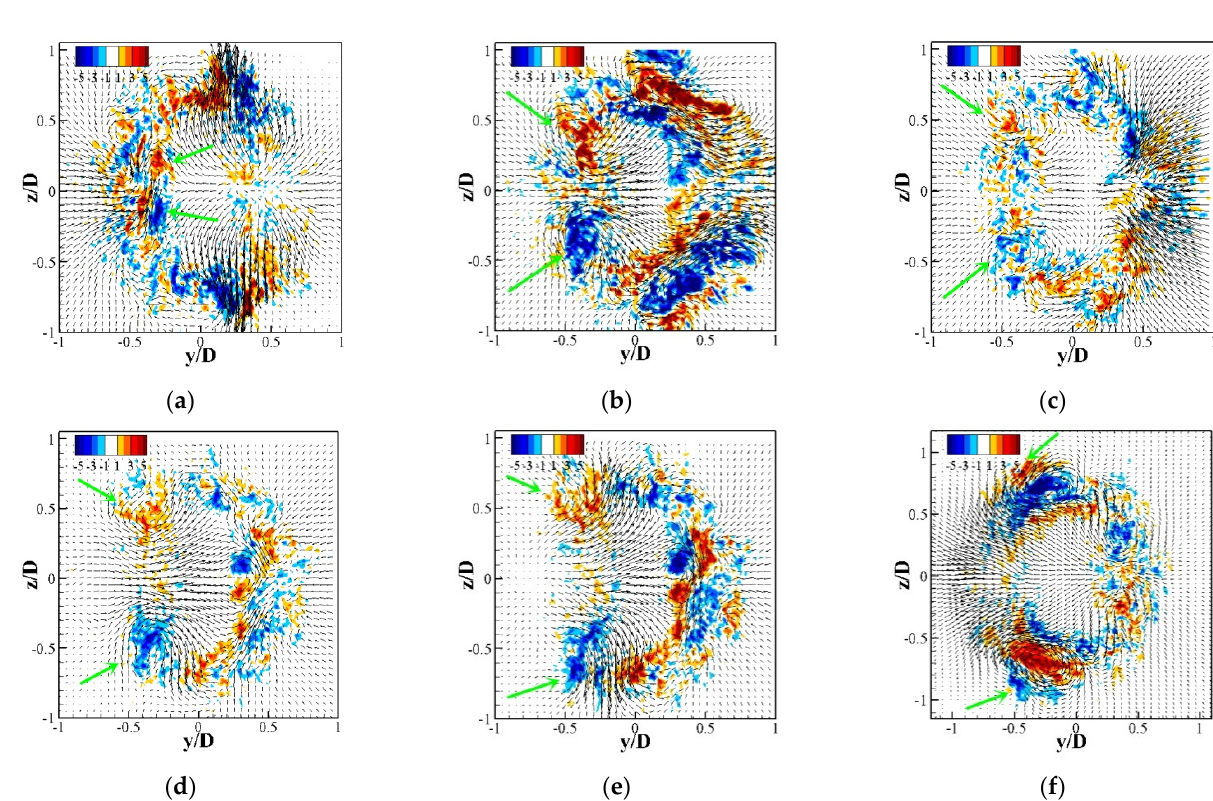
Figure 18. Streamwise vorticity and in-plane velocity vectors for the MFR = 0.67% case at the x / D = 2 cross-sectional plane in a time sequence, normalized by U j / D . ( a ) t = 0.875 T, ( b ) t = 1 T, ( c ) t = 0.125 T, ( d ) t = 0.3 T, ( e ) t = 0.35 T, ( f ) t = 0.47 T.